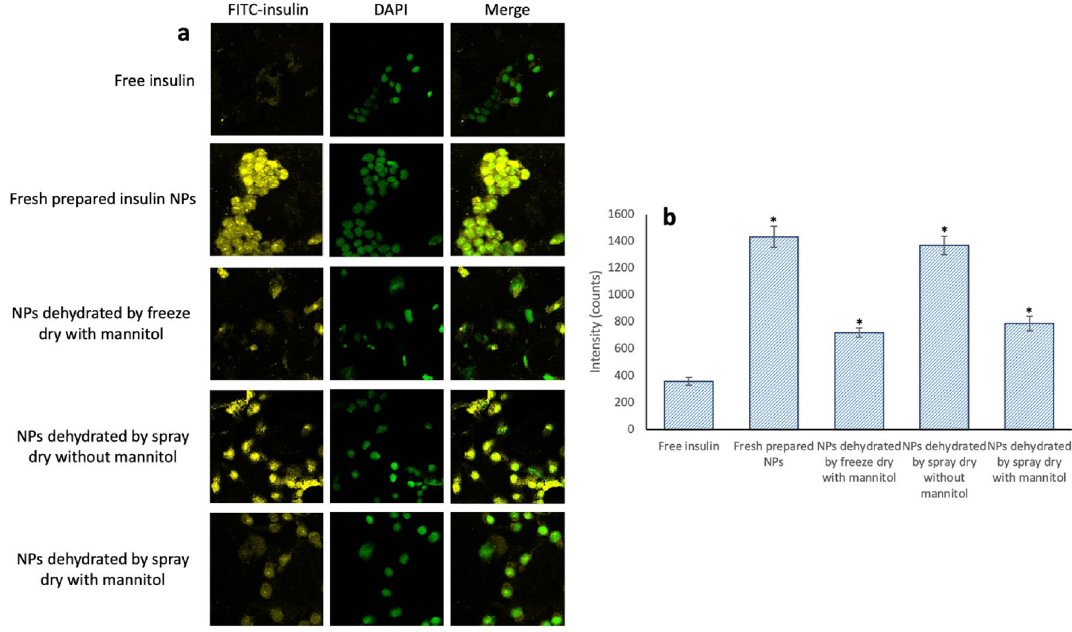
Figure 6. HepG2 cellular uptakes after 4 h incubation with fresh prepared NPs and dehydrated NPs: ( a ) Distribution of FITC-insulin uptaken by HepG2 cells. ( b ) Geometric mean values of the fluorescence intensities of the flow cytometry analysis ( n = 3), * P < 0.05 compared with free